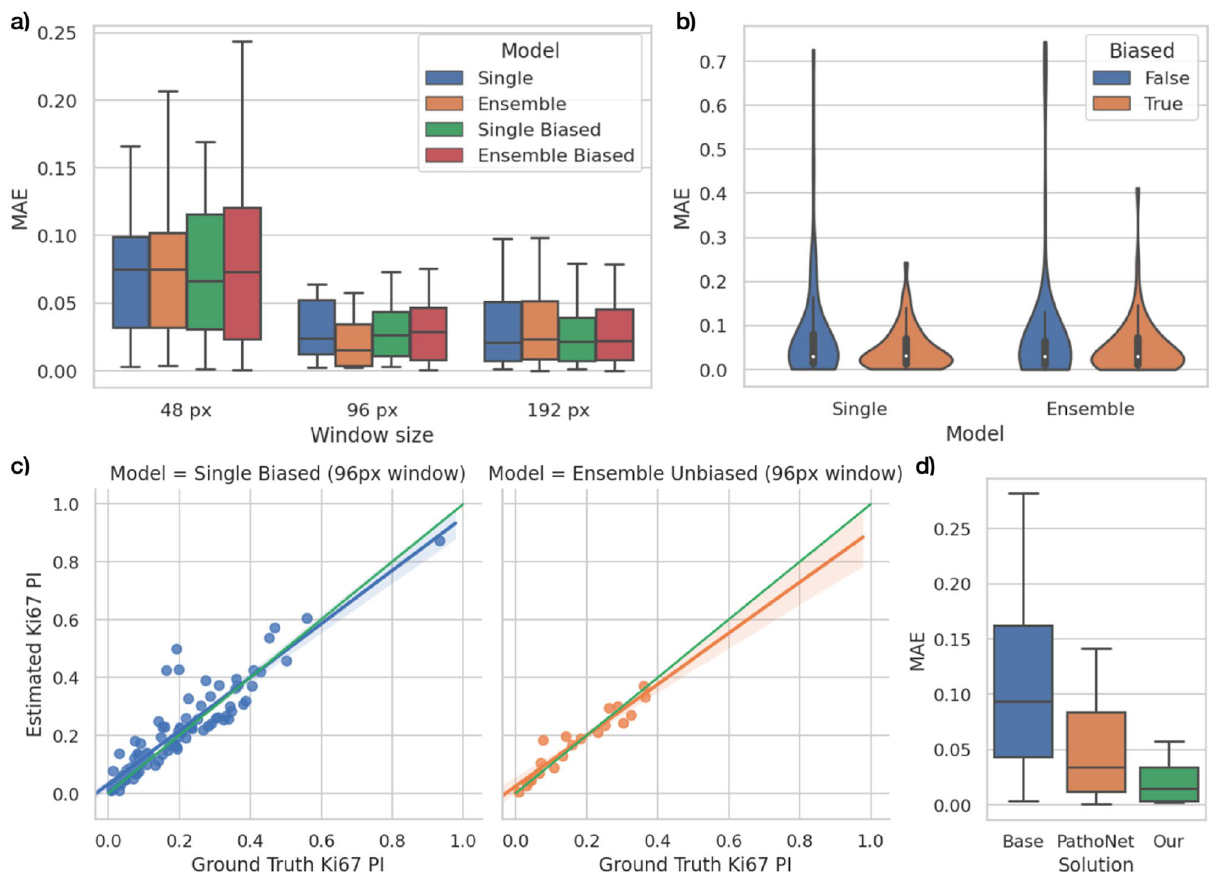
Figure 5. The results of Ki-67 proliferation index estimations: ( a ) presents MAE medians and their distribution for a subset of 20 images with excluded outliers, ( b ) shows the impact of the applied biasing onto reducing outstanding Ki67 PI errors, ( c ) sets linear regression from the best methods (“single biased” and “ensemble unbiased”), ( d ) comparing our best solution (ensemble 96 px-window unbiased) with PathoNet and the “base”